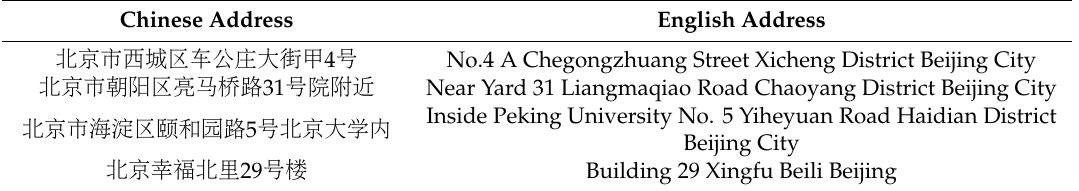
Table 3. Examples of point of interest (POI) address data.